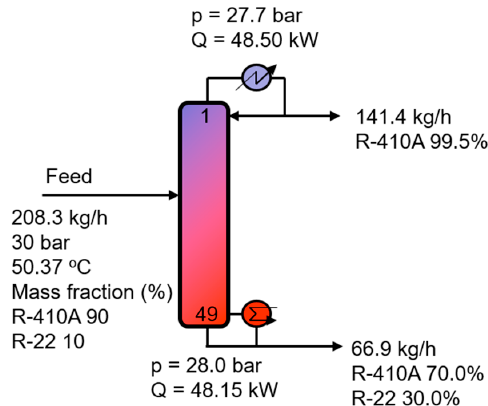
Figure 1. Schematic of the heat pump systems: ( a ) mechanical vapor recompression heat pump, ( b ) vapor recompression heat pump, and ( c ) new heat pump system.